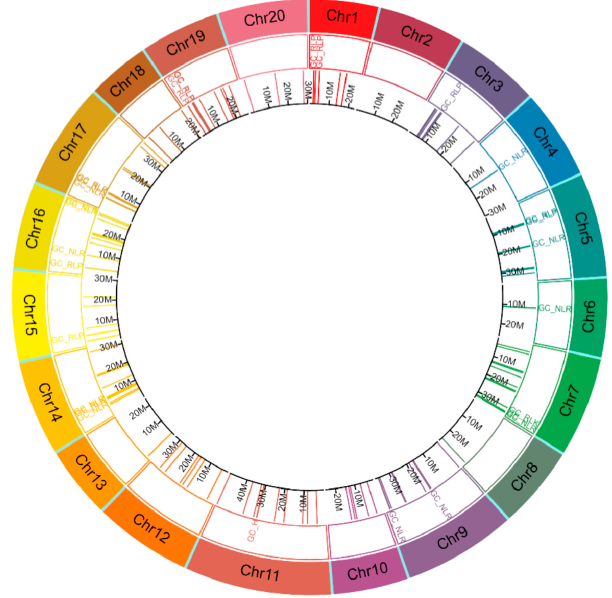
Figure 5. Distribution of cloned disease resistance gene homologs in Camelina sativa (1st inner layer in their corresponding position in C. sativa genome). The tracks in the circos plot, from outer to inner, show chromosome (Chr) number and types of gene cluster. GC_NLR = gene cluster (GC) with all nucleotide-binding site leucine rice repeats (NLR) members, GC_RLP = GC with all receptor-like proteins (RLP) members, GC_RLK = GC with all receptor-like kinase proteins (RLK) members, GC_H = GC with members are a mixture of NLR, RLK and/or RLP, Chr = chromosome and M = position in million base pairs.